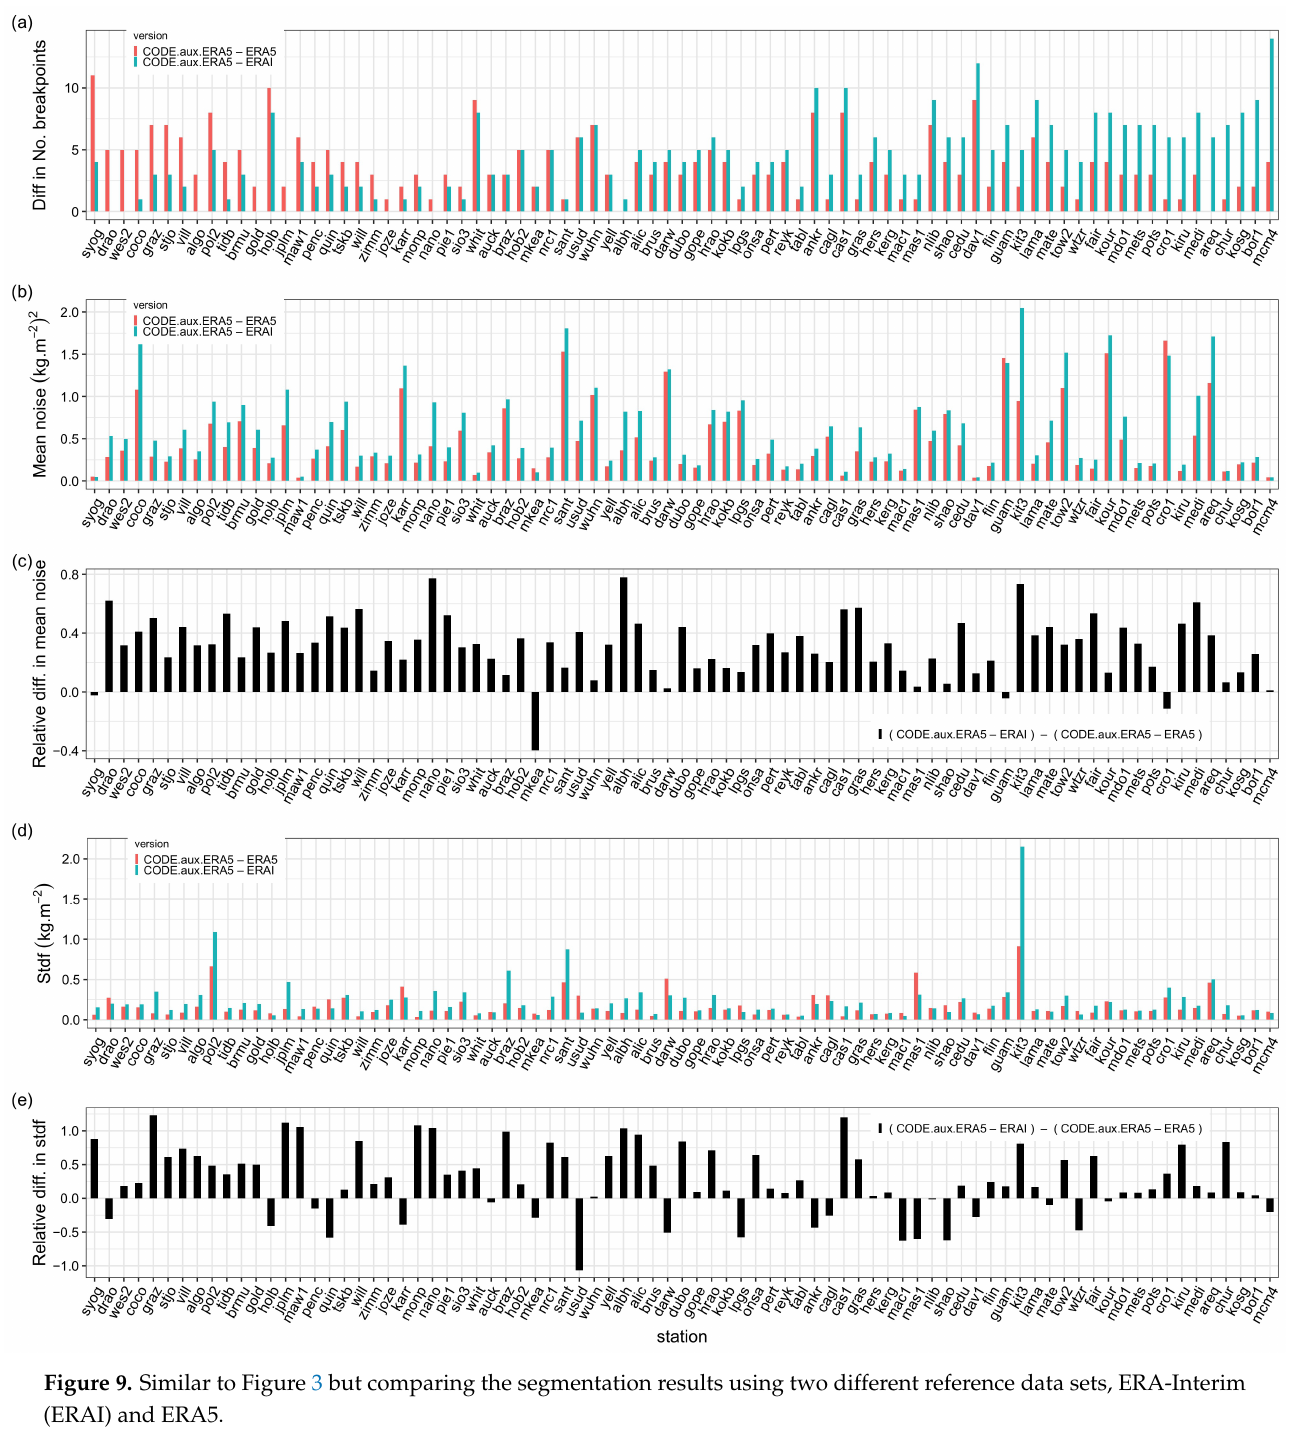
Figure 9. Similar to Figure 3 but comparing the segmentation results using two different reference data sets, ERA-Interim (ERAI) and